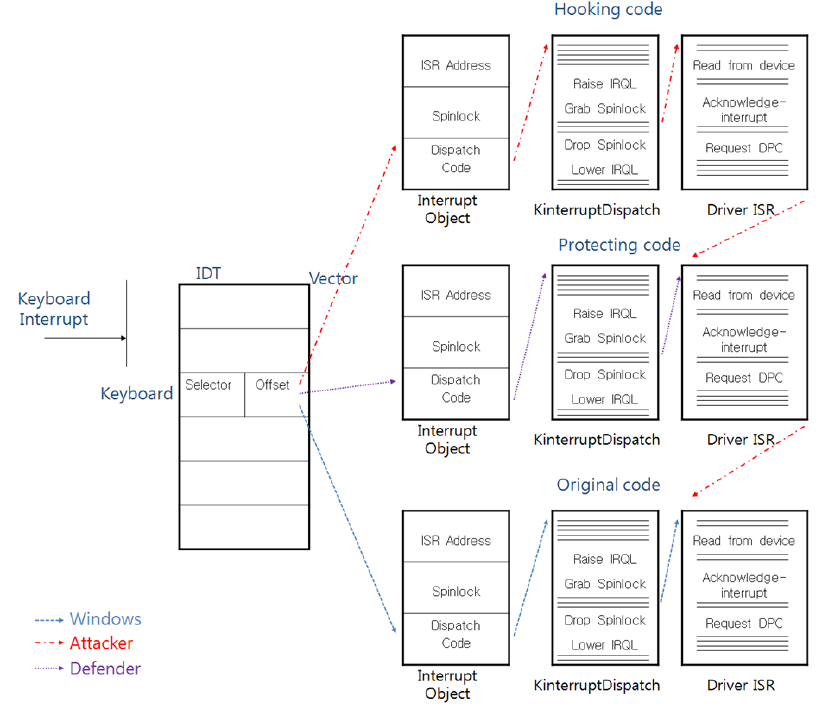
Figure 7. The attack technique that neutralizes the countermeasure against the IDT-hooking at- tack.